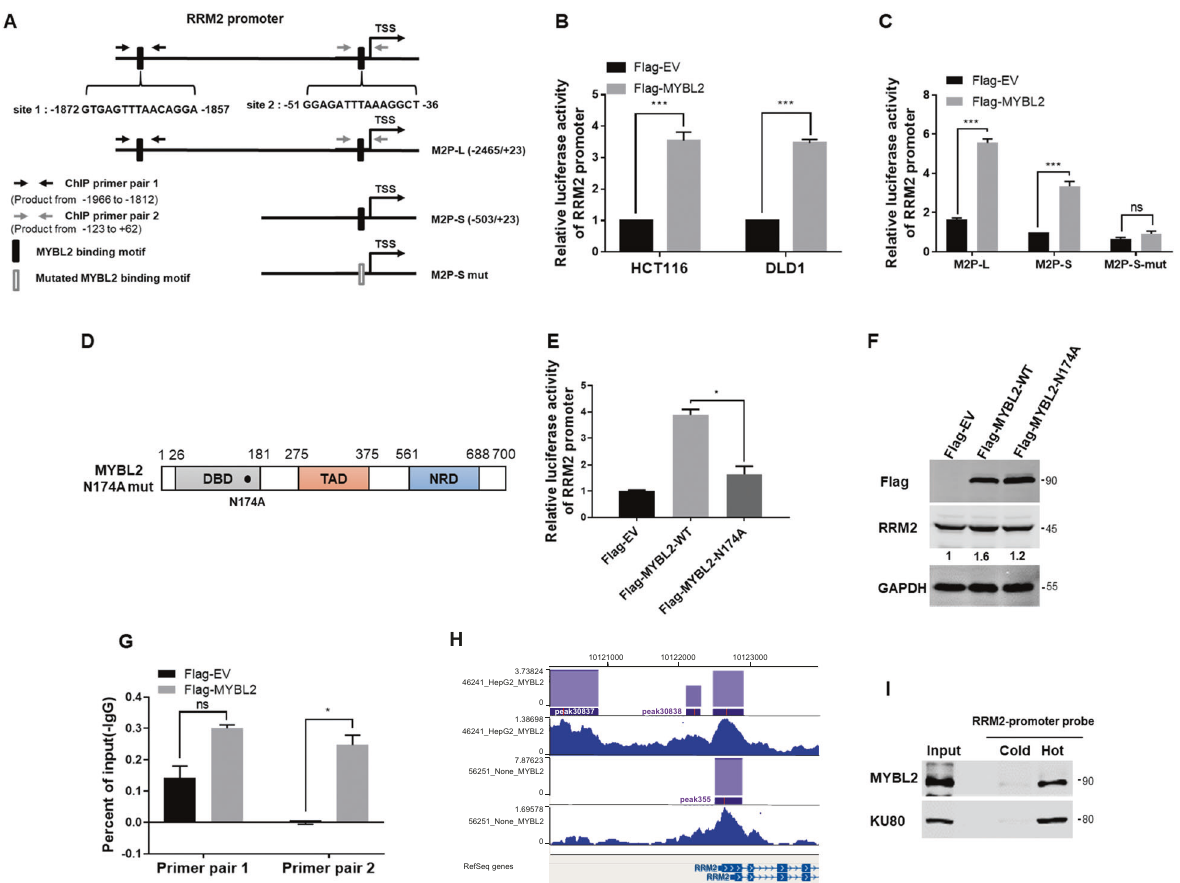
Fig. 3 MYBL2 activated the transcription of RRM2 by directly binding to RRM2 promoter in CRC cells. A The schematic diagram for two MYBL2 biding motifs on RRM2 promoter and related truncated and site-mutated sequences. B Relative luciferase reporter activity of RRM2 promoter ( − 2465/ + 23) while co-transfected with MYBL2 expression plasmid for 48 h in HCT116 and DLD1 cells, respectively, pRL-SV40 as an internal control reporter. C Relative luciferase reporter activity of the truncated and mutated RRM2 promoters while co-transfected with MYBL2 expression plasmid for 48 h in DLD1 cells, pRL-SV40 as an internal control reporter. D The DNA-binding de fi cient mutation site in MYBL2 protein. E Relative luciferase reporter activity of RRM2 promoter ( − 2465/ + 23) while co-transfected with MYBL2 wild-type or N174A mutant. F The effects of overexpression of MYBL2 wild-type or N174A mutant on the expression of RRM2 in DLD1 cells. G Chromatin extracted from DLD1 cells was immunoprecipitated with the Flag or IgG antibodies, qRT-PCR were carried out on the immunoprecipitated DNAs using the speci fi c primer pairs for the RRM2 promoter. H The ChIP-Seq data from Cistrome browser showed the binding of MYBL2 to RRM2 promoter in HepG2 cells. I Nuclear proteins obtained from DLD1 cells were pulled down by a non-biotin-labeled (cold) or biotin-labeled (hot) RRM2 promoter ( − 2465/ + 23) DNA probe, western blotting was used to detect the binding of MYBL2 or Ku80 (loading control). Unpaired Student ’ s t -test (2-tailed) was used to analyze the signi fi cance between different groups. ns, not signi fi cant; * p < 0.05; *** p <